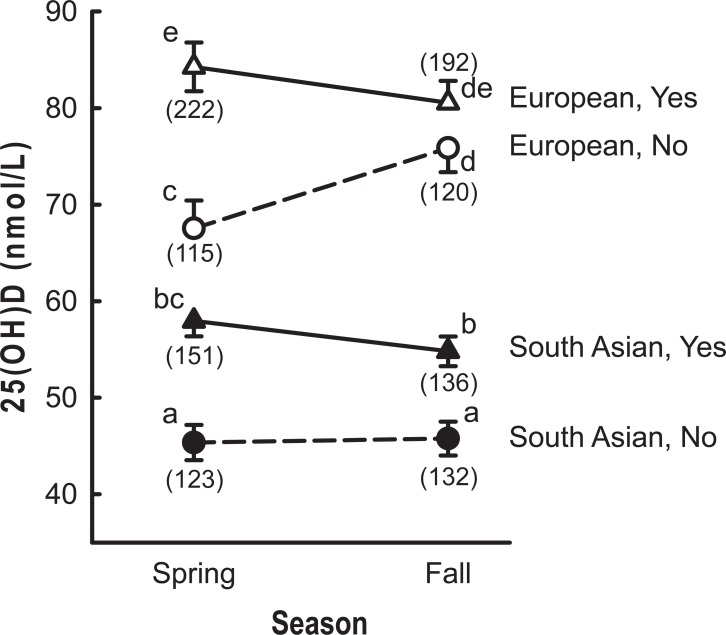
LSE serum 25OHD values as a function of season, ethnic background and consumption of vitamin D containing supplements (Yes/No).Values represent mean ± standard error. Open symbols represent participants of European descent and filled symbols represent those of South Asian descent. Triangles represent participants consuming supplements while circles represent participants who did not consume supplement. Symbols with different superscripts differ significantly (P<0.05). The number of participants in each category is indicated below the symbol in parentheses.